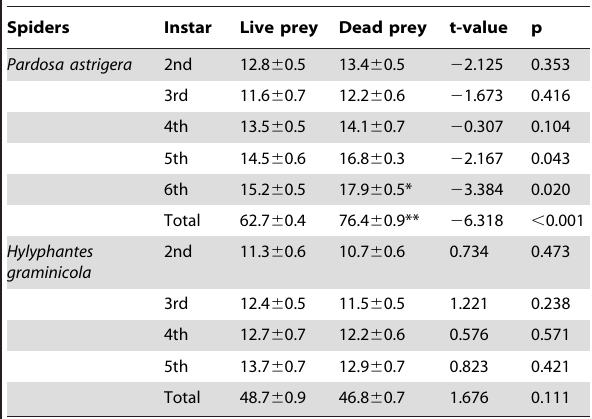
Table 1. Average developmental period (days 6 SE) of Pardosa astrigera and Hylyphantes graminicola fed with live and dead flies as prey.